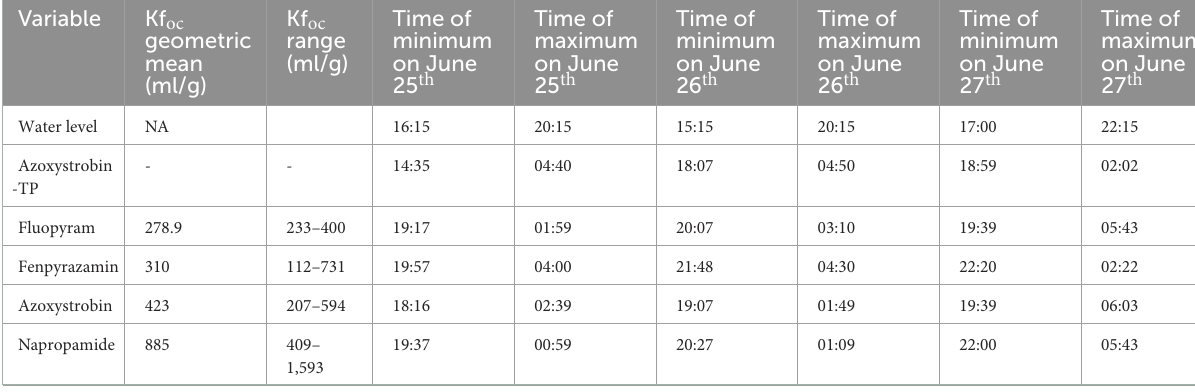
TABLE 3 Timing of minima and maxima of water levels and of concentrations of those PPPs and TPs that showed diel fluctuations analyzed in the time window from June 25 th to June 28 th . Variable